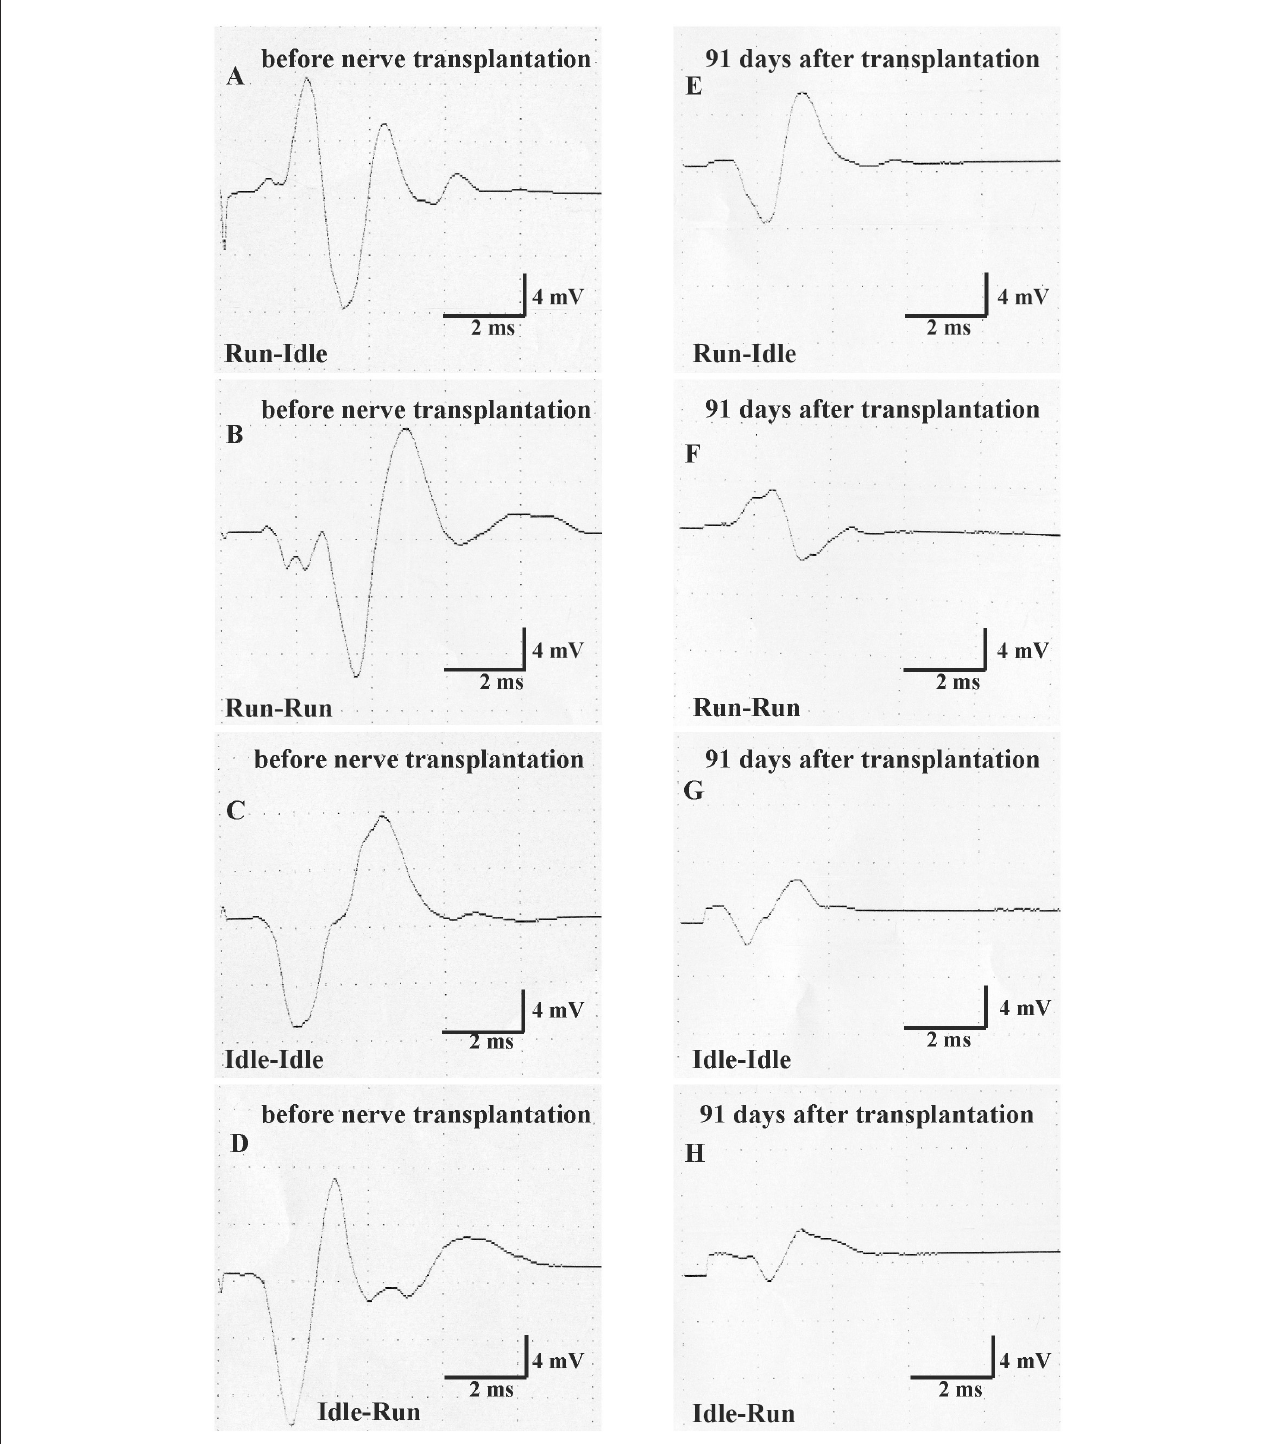
FIGURE4 Motor nerve conduction test (MNCT). The evoked compound muscle action potential of the soleus muscle was measured first immediately before nerve transplantation in all four groups (normal CMAP, A–D ), and second 91 days after sciatic nerve transplantation (regenerated CMAP, E–H ).